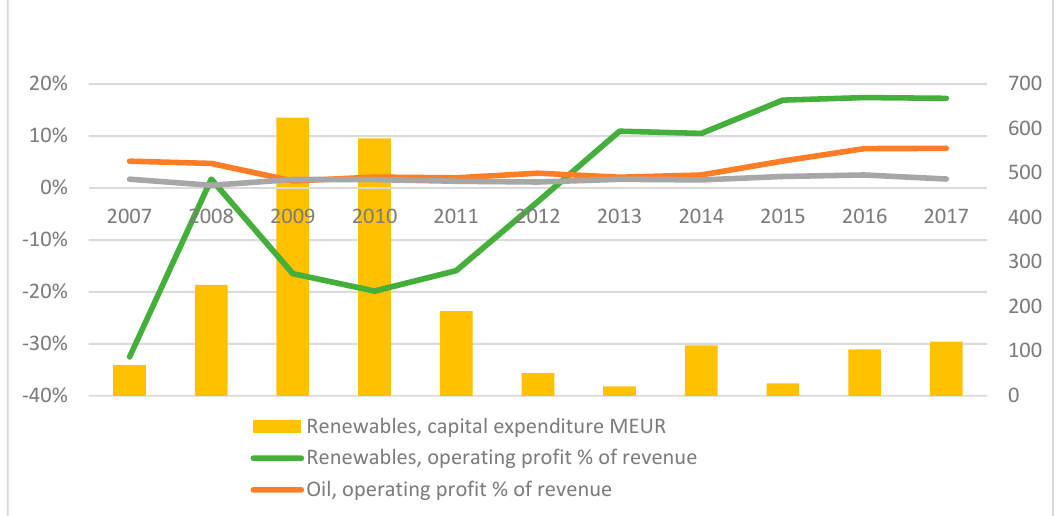
Figure 4. Neste Biofuel investments and operating profits. Source: